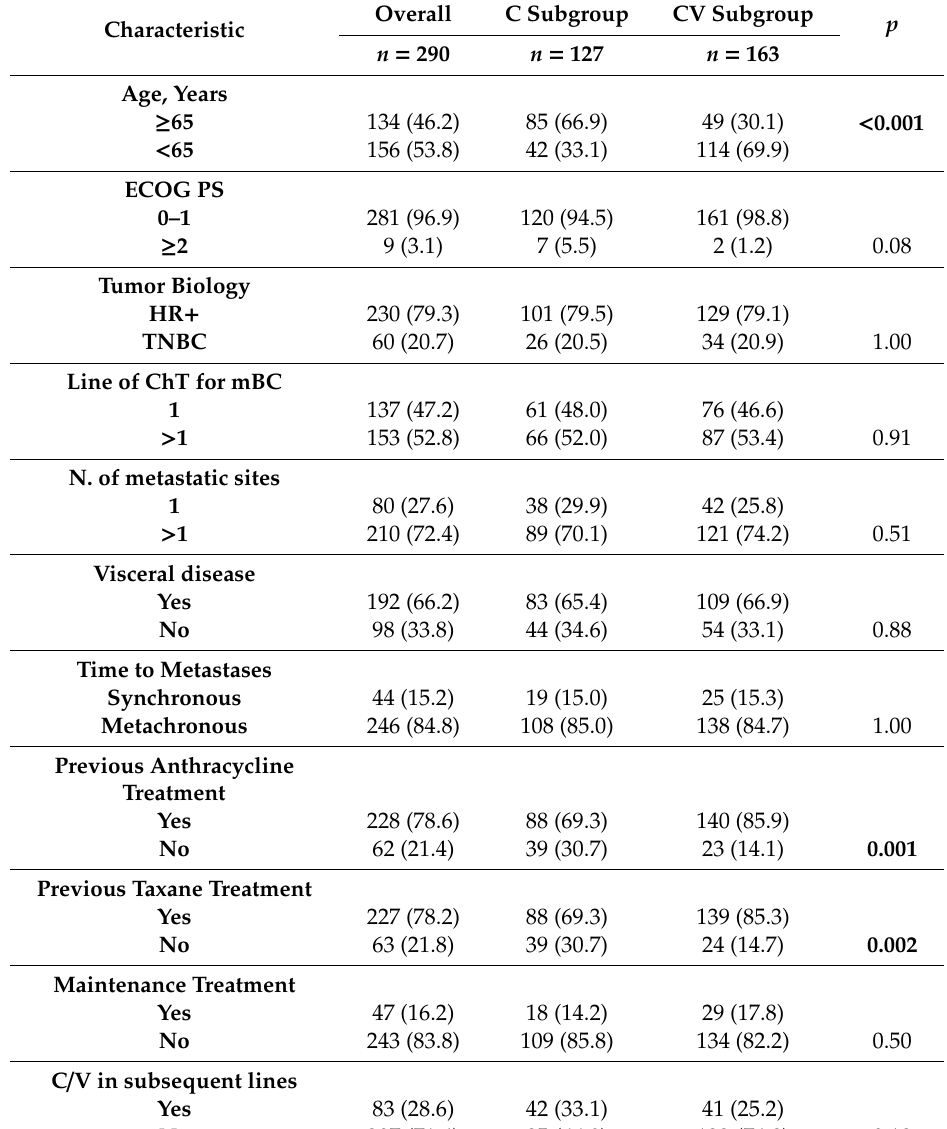
Table 1. Clinical and tumor characteristics in the overall population and in the C and CV